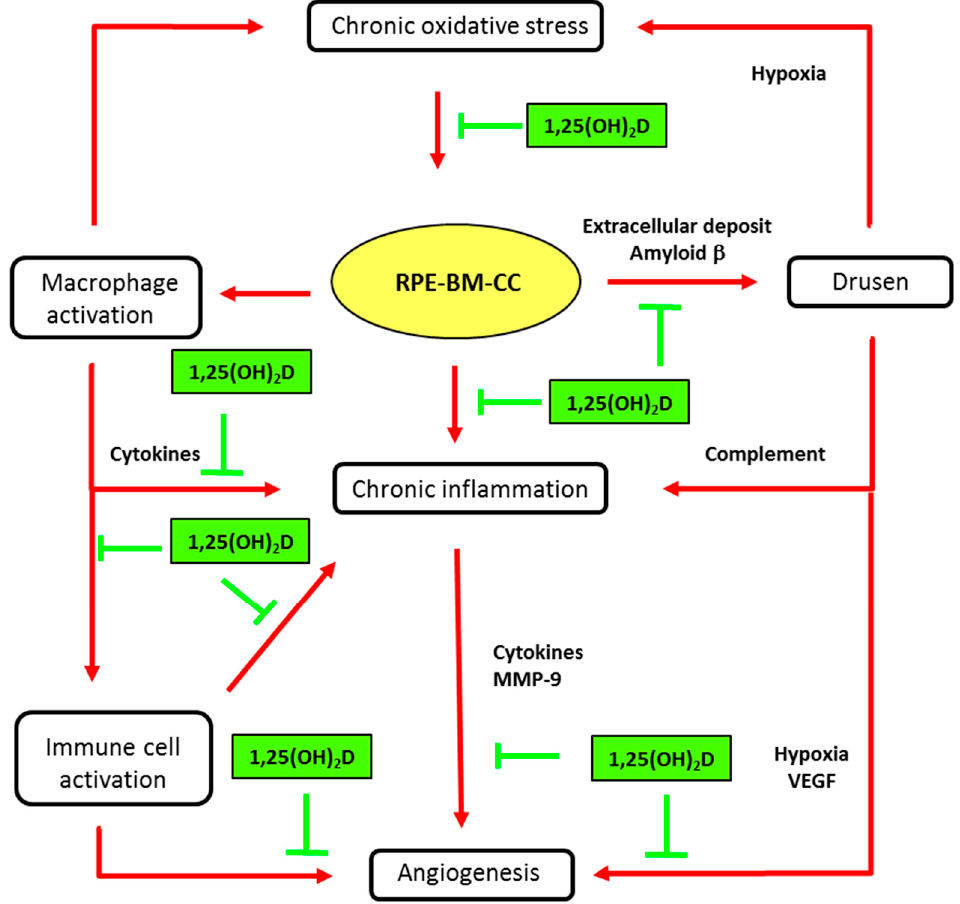
Figure 3. Main biological mechanisms in age-related macular degeneration (AMD) and putative vitamin D effects. Inhibitory activities of vitamin D (1,25(OH) 2 D) are indicated in green truncated arrows and mechanisms of AMD pathophysiology in red arrows. AMD is characterized by progressive degeneration of the macula, involving the retinal pigment epithelium (RPE), the Bruch’s membrane (BM), and alterations in choroidal capillaries (CC). Chronic oxidative stress in senescent RPE is a key event in maintaining macular damage and initiating early AMD. The release of cell debris and the accumulation of specific deposits (drusen) is the hallmark histopathological feature of eyes with early and intermediate AMD. Vitamin D may prevent the risk for developing early and intermediate AMD, by inhibiting oxidative stress, inhibiting extracellular amyloid deposits and inhibiting macrophage activation. Advanced dry AMD is characterized by atrophy of RPE cells and choriocapillaries. RPE dysregulation, due to oxidative stress and inflammatory reactions, may lead to abnormal angiogenesis, leading to neovascular AMD. Vitamin D may reduce the risk or slow the development of neovascular AMD by inhibiting angiogenesis or immune cell activation (see text for details).